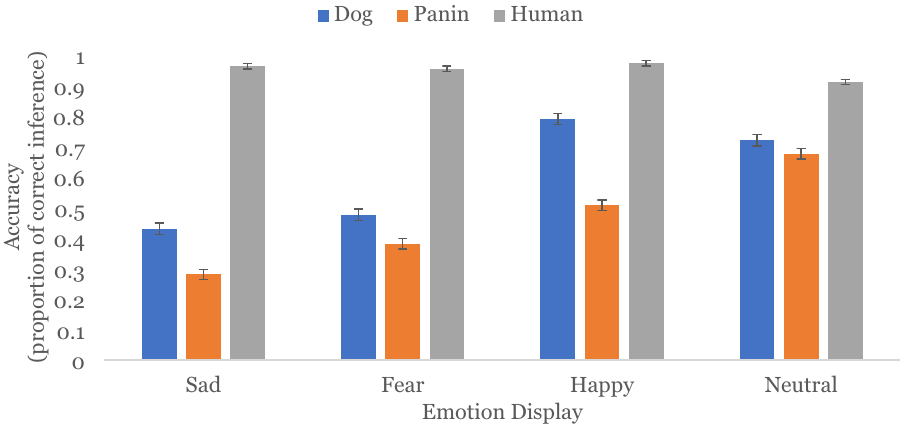
Figure 1. Proportion of accurate emotion inferences from facial displays in Study 1. Error bars represent standard error. All bars within emotion category are significantly